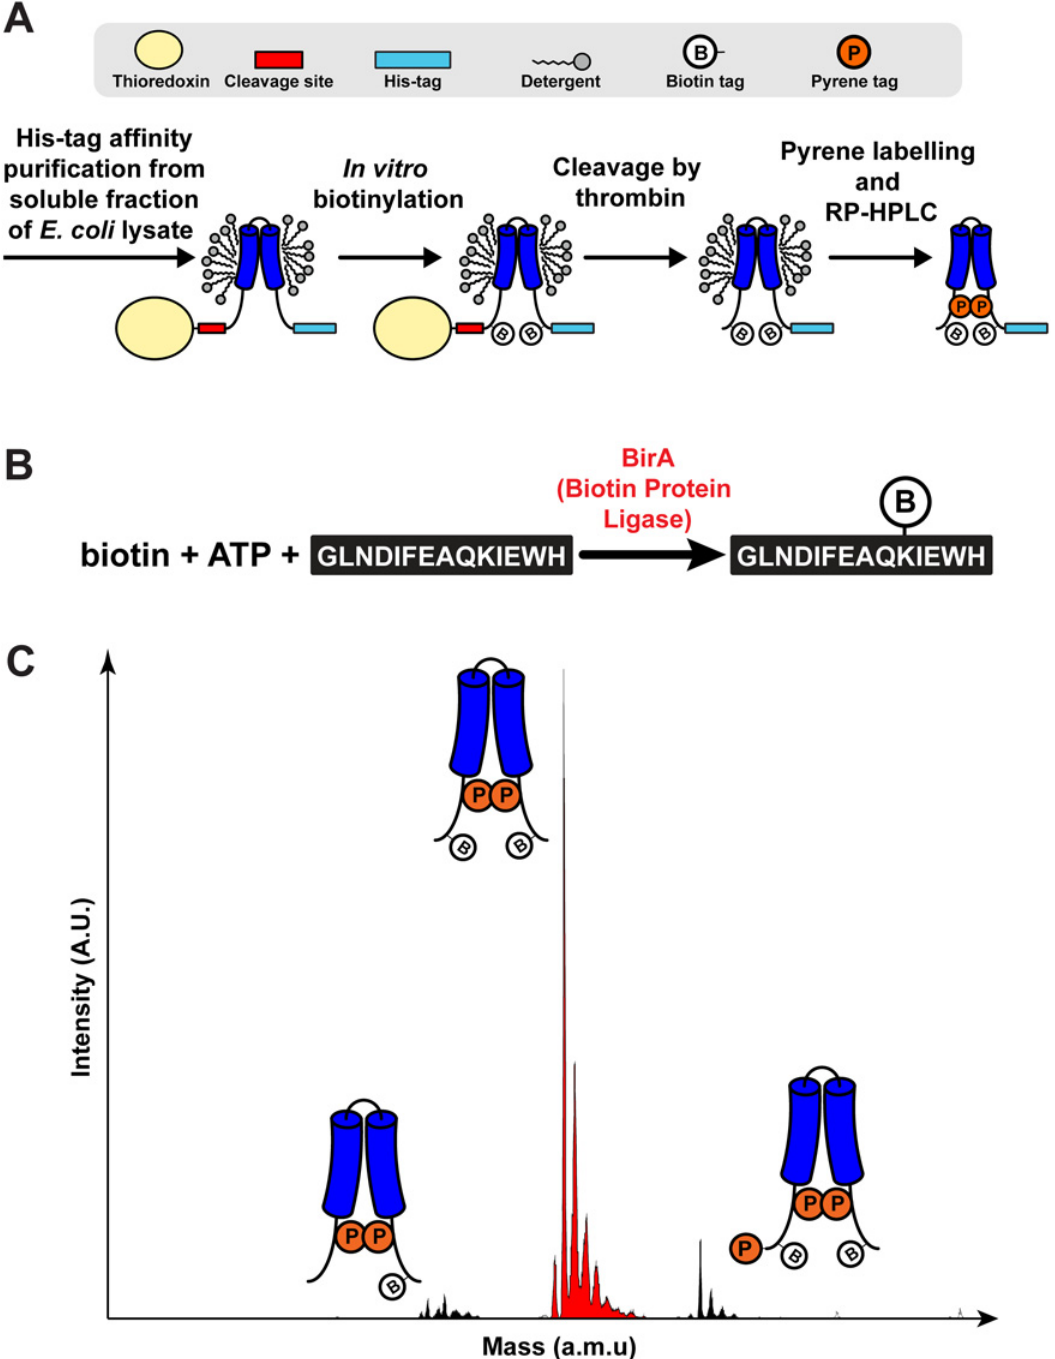
Fig 2. Preparation of unfolding-competent CFTR TM3/4 constructs. ( A ) Purification and labelling scheme to obtain TM3/4 constructs. Following His-tag affinity purification from the soluble fraction of E . coli lysates, constructs are biotinylated in vitro using the reaction shown in ( B ). Then, biotinylated constructs are cleaved by thrombin to remove the solubilizing thioredoxin moiety, and labeled with pyrene iodoacetamide at each of two cysteine residues. Constructs are purified from excess reagents, cleaved thioredoxin, and detergent, by RP-HPLC. ( B ) In vitro biotinylation reaction scheme using free biotin, ATP, and purified biotin protein ligase (BirA). This reaction targets Lys 10 in the biotin acceptor peptide sequence [21] inserted in TM3/4 water-soluble region by site- directed mutagenesis (see Methods). ( C ) Typical mass spectrum for a purified CFTR TM3/4 construct, highlighting the predominance of a doubly biotinylated and pyrene-labeled version ( red ). Trace amounts of constructs with only one biotin tag or with an extra pyrene label are still present after purification ( black ).